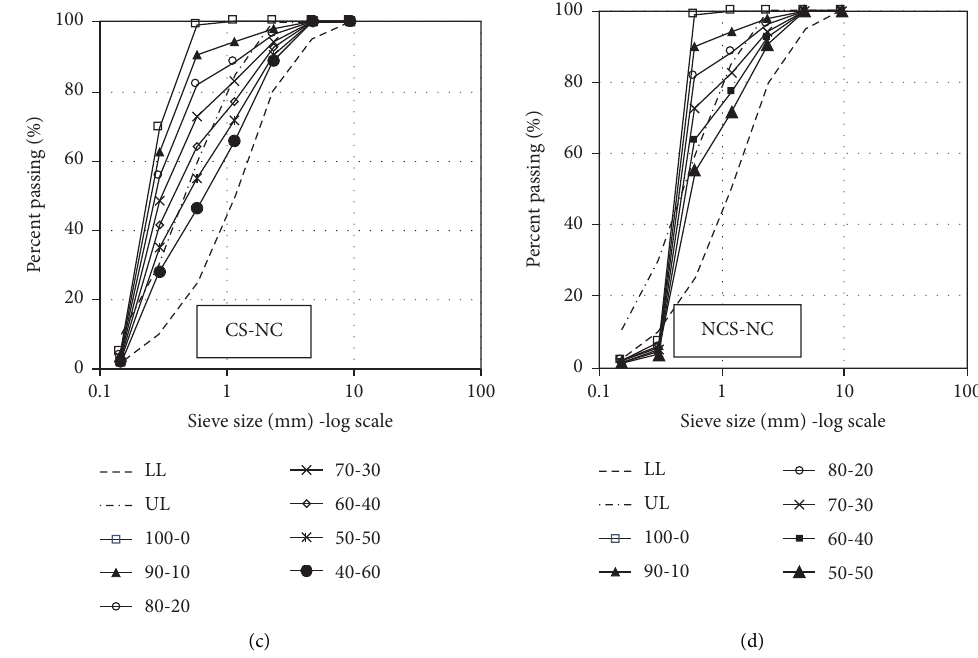
Figure 3: Combined enhanced gradation curves (a) Ravi sand combined with normalized quarry dust, (b) normalized Ravi sand combined with normalized quarry dust, (c) Chenab sand combined with normalized quarry dust, and (d) normalized Chenab sand combined with normalized quarry